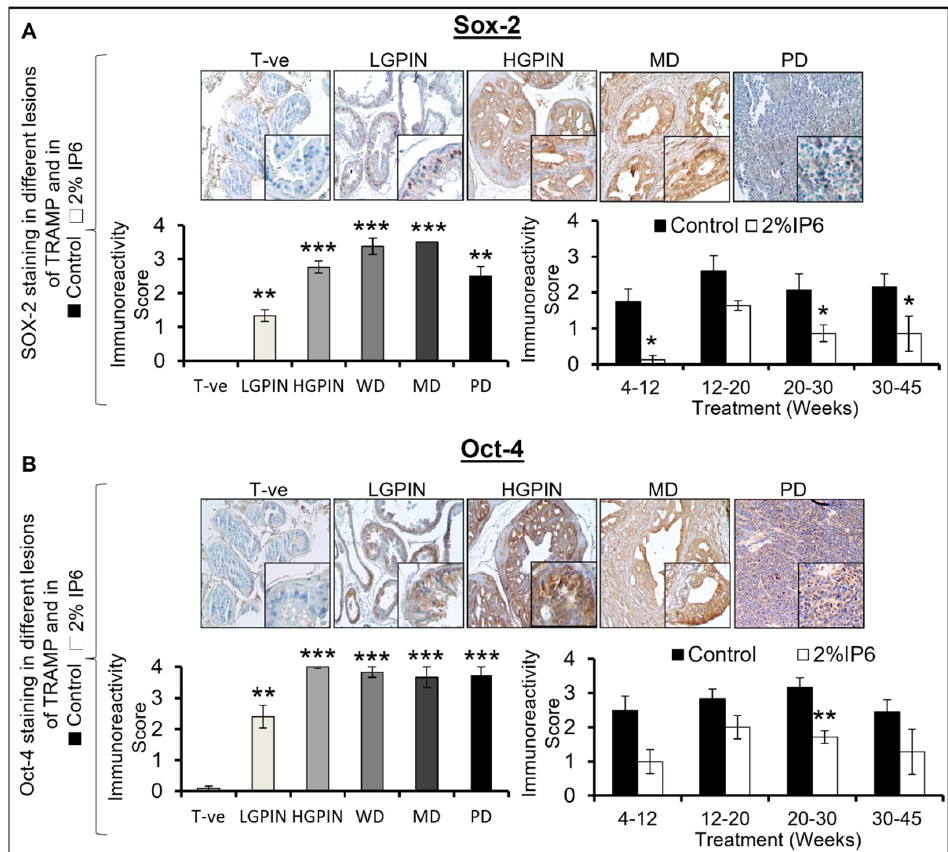
Figure 8. Stage-specific effect of IP6 feeding on the expression of CSC-associated transcription factors in the dorsolateral prostate of TRAMP mice. Pictographs and bar graphs representing the stage-specific expression of CSC-associated transcription factors ( A ) Sox-2, and ( B ) Oct-4, in WT control (Tr-ve), TRAMP control, and IP6-fed mice. Representative pictographs are depicted at ×100 magnification and insets represent digital magnifications. Immunoreactivity was scored as 0 (no staining), +1 (weak), +2 (moderate), +3 (strong), and +4 (very strong). Quantified data are represented as mean ± SEM. *** p ≤ 0.001, ** p ≤ 0.01, and * p ≤ 0.05 .